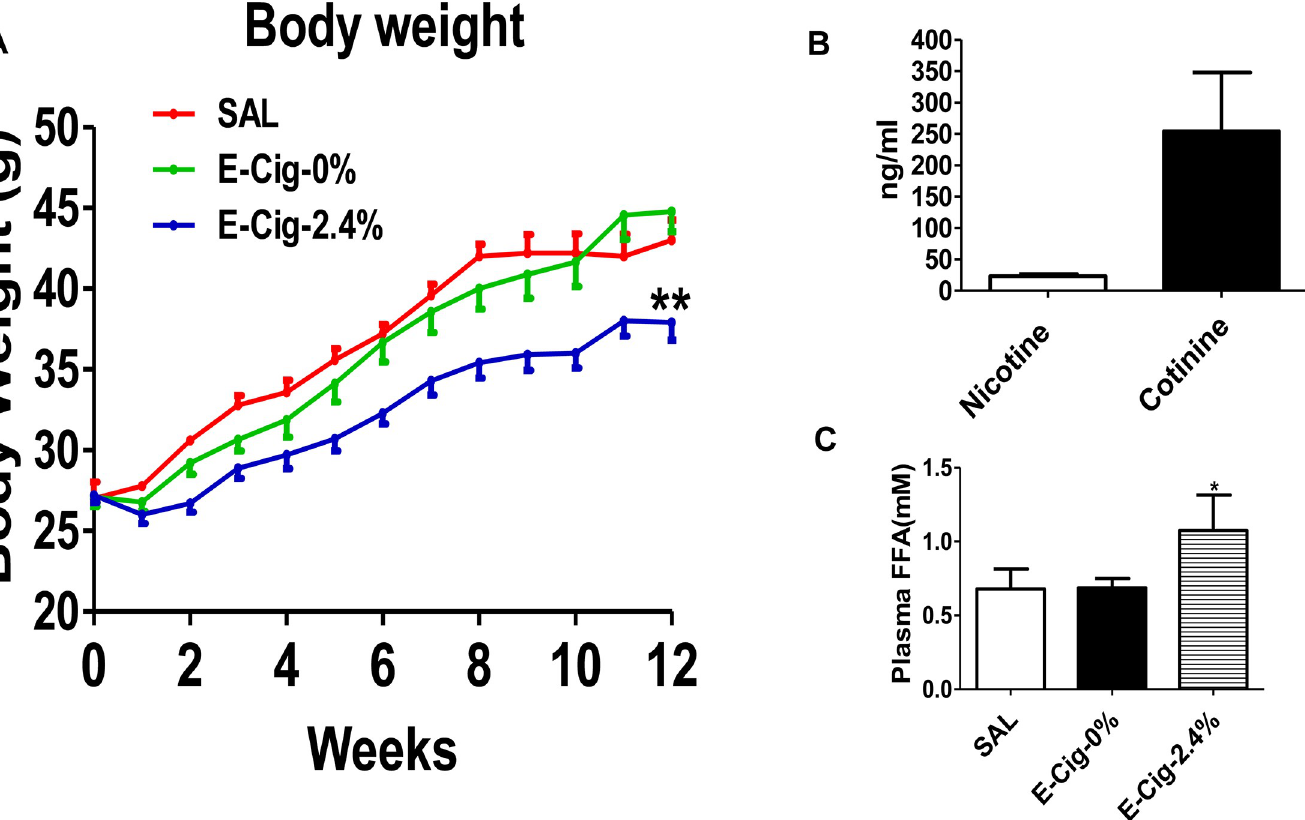
Fig 1. Body weight and plasma nicotine, cotinine, and FAA levels. ( A ) Body weight measured over 12 weeks in mice exposed to saline and e-cigarettes in the absence or presence of nicotine. Nicotine delivered through e-cigarettes (2.4% nicotine) significantly reduces body weight in mice on an HFD compared to HFD-fed mice exposed to saline or e-cigarette (0% nicotine) aerosol. There is no difference in body weight between mice on an HFD exposed to saline or e-cigarette (0% nicotine) aerosol. ( B ) Plasma nicotine and cotinine levels in mice exposed to e-cigarette. ( C ) Plasma FAA levels in e-cigarette and saline-exposed mice. Values are given as means ± SE of 5 mice per group. � P < 0.05; �� P <